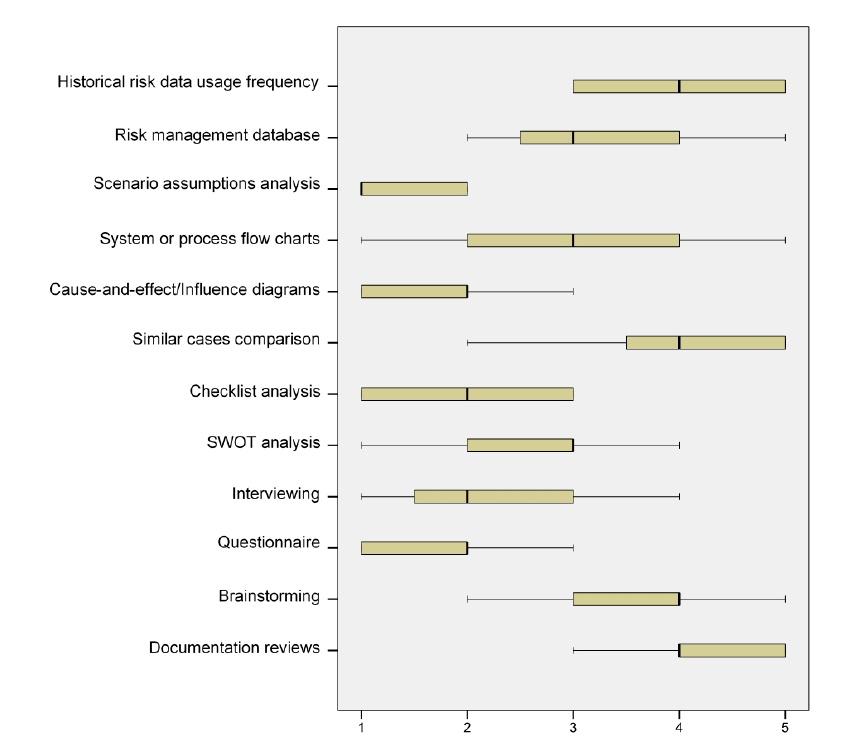
Figure 6. Risk identification tools used by the companies.